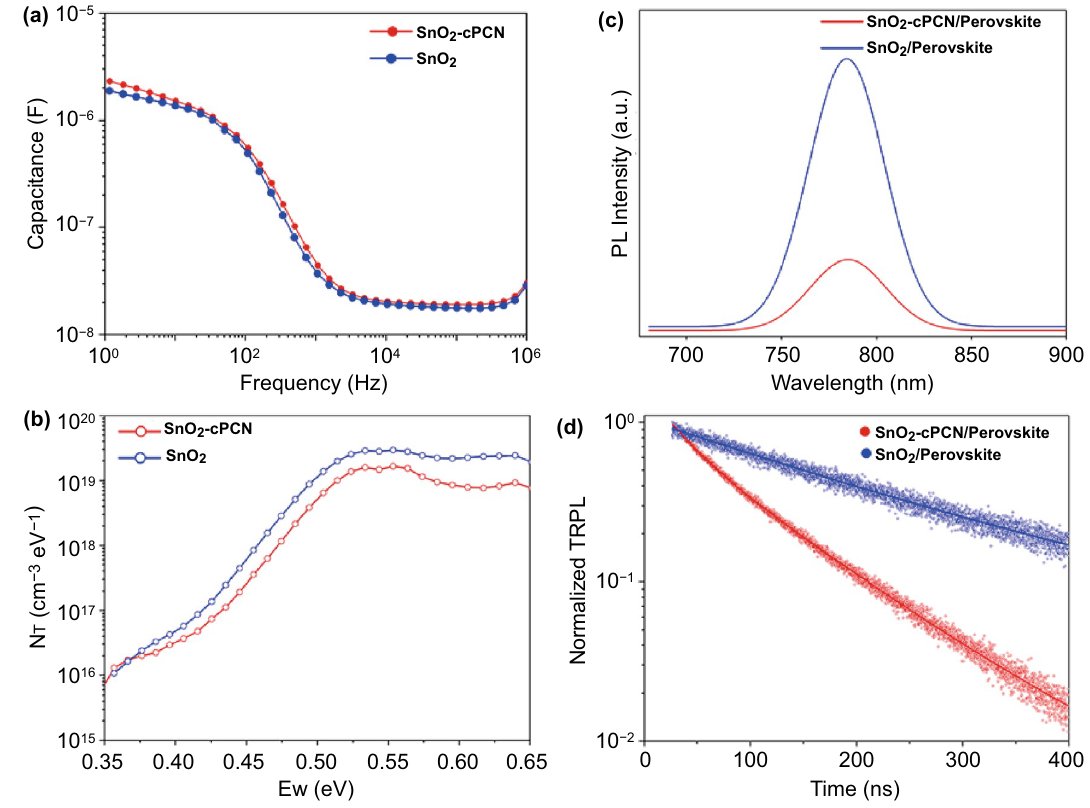
Fig. 5 a Frequency-capacitance measured from perovskite devices on the SnO 2 -cPCN and SnO 2 ETL. b Trap density of states (tDOS) for devices with SnO 2 -cPCN and SnO 2 ETL. c Steady-state PL and d TRPL spectra of perovskite films deposited on different